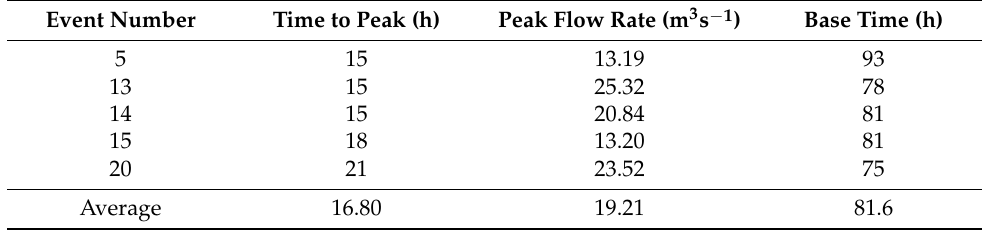
Table 1. Characteristic of selected storm events in the Nenagh